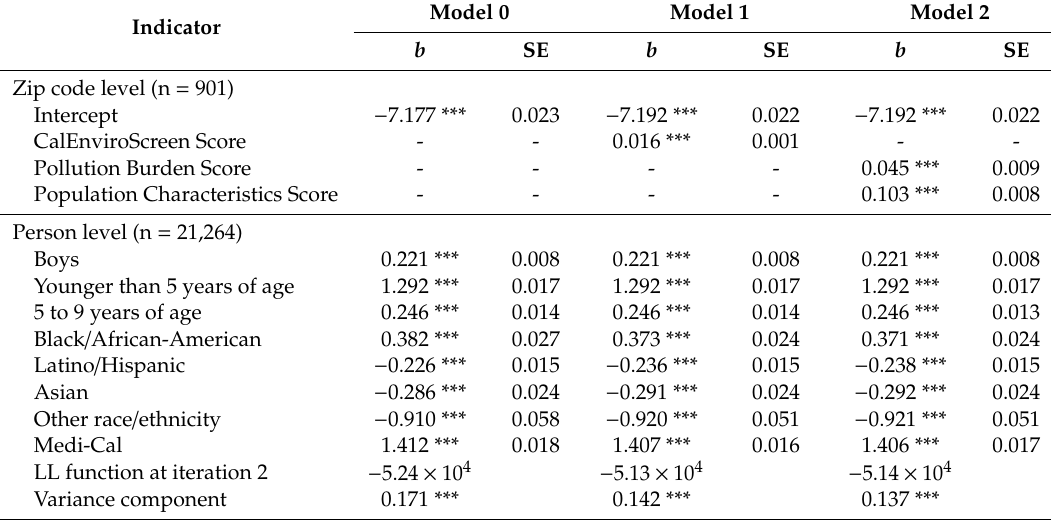
Table 3. Rates of asthma hospitalizations estimated by hierarchical generalized nonlinear regression models by zip-code-level and individual-level indicators, 2010–2012,